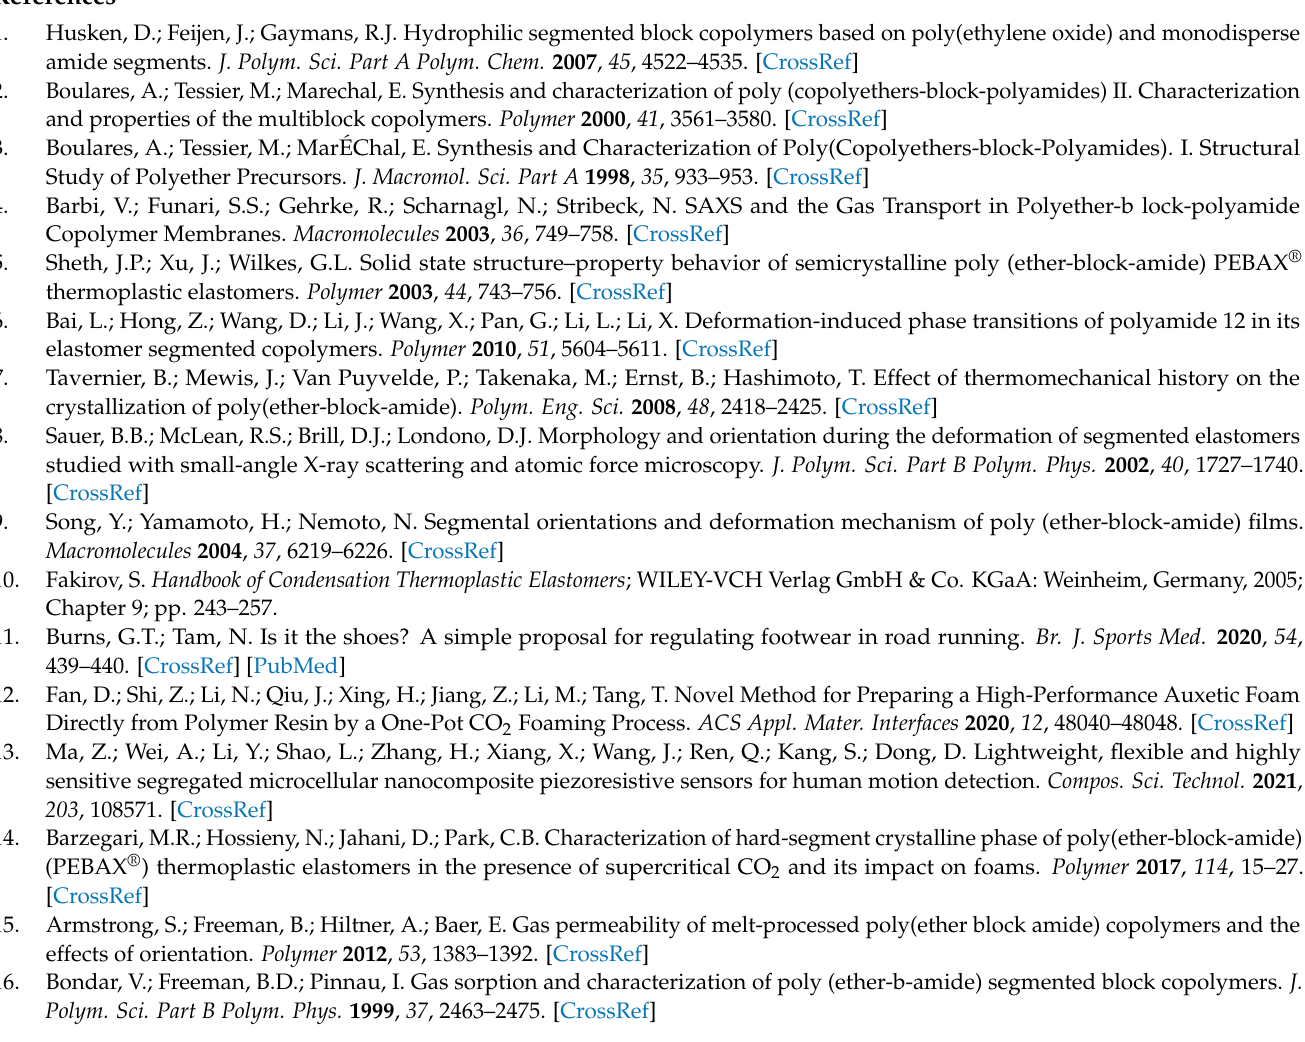
.3390/polym13162645/s1, Figure S1: DSC thermogram of Jeffamine D2000, Figure S2: DSC thermo- gram of TPAEs, Figure S3: POM images of (a) (b) TPAE-0.39, (c) TPAE-0.25 (d) TPAE-0.10, (e) homo PA1212, Figure S4: Photos of specimens before and after cyclic tensile testing for (a) TPAE-0.76 and (b) TPAE-0.43 (stored at room temperature overnight), Figure S5: Thermal gravimetric curves of TPAEs, Table S1: The residual strain of the specimens after cyclic tensile testing, Table S2 Characteristic thermal degradation parameters of